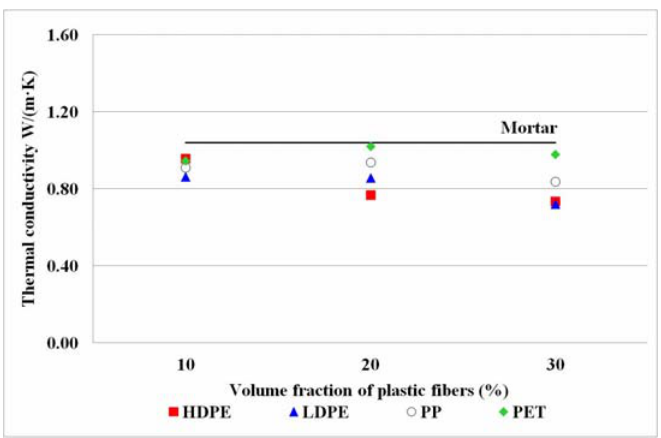
Figure 6. Thermal conductivity of produced concrete. The thermal conductivity of mortar (control sample) is in the solid line.